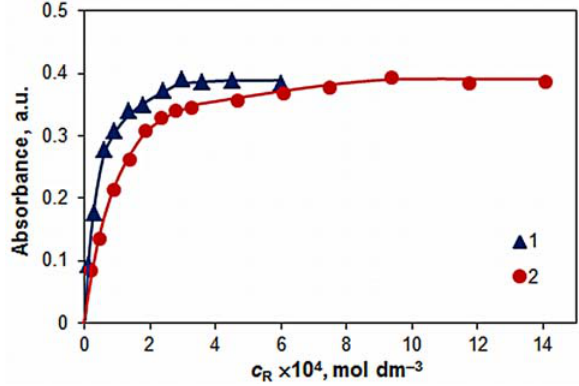
Figure 3. Absorbance of extracted complex vs concentration of the reagents (R): 1. R = TAO, c 10 –4 mol dm –3 , pH 5.0, λ = 545 nm; 2. R = TTC, c